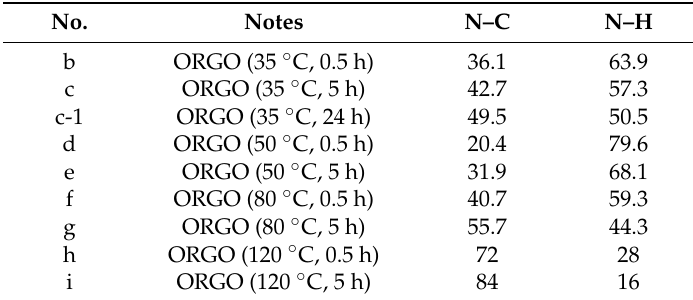
Table 2. The aspect ratio of different N in the XPS N 1s spectra.